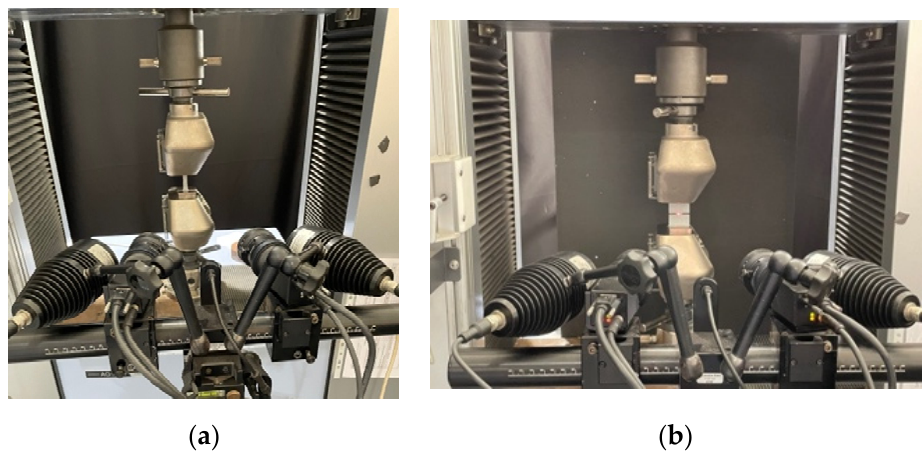
Figure 5. Testing setup for tensile test ( a ) and plane strain test ( b ).